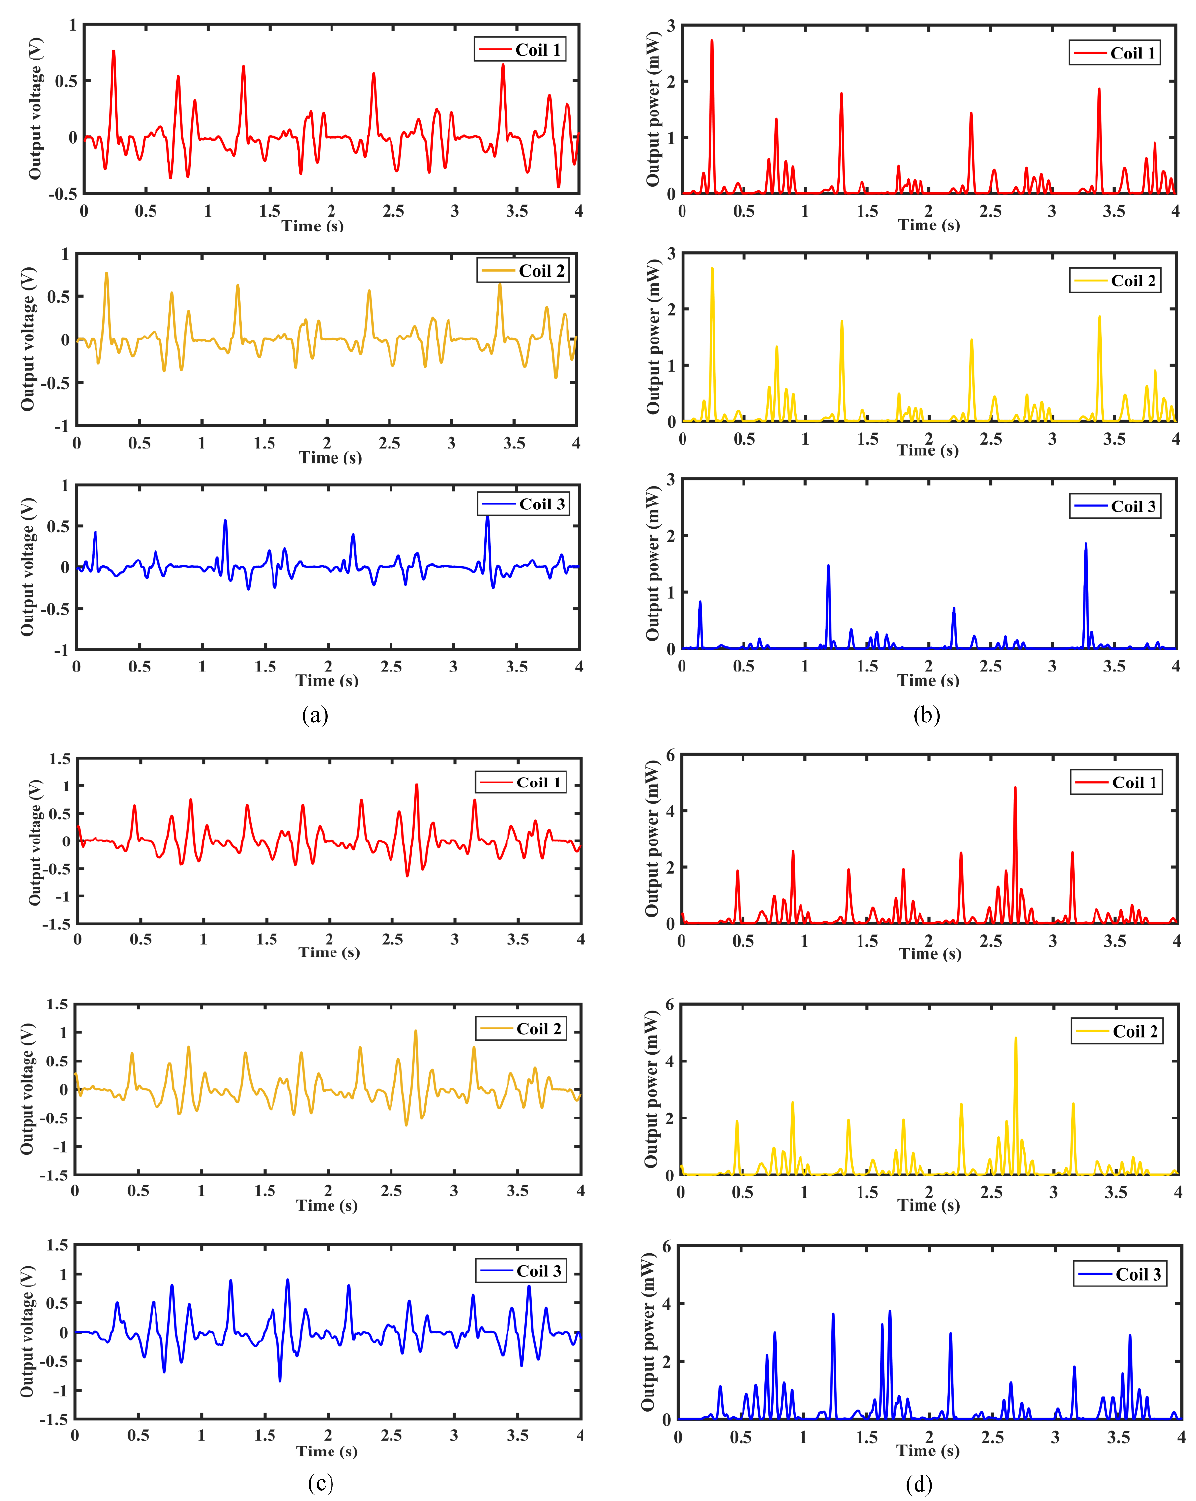
Figure 14. Output of the MCEEH installed parallel to the leg: ( a ) output voltage for moving speed at 3 km/h; ( b ) instanta- neous power output for moving speed at 3 km/h; ( c ) output voltage for moving speed at 6 km/h; ( d ) instantaneous power output for moving speed at 6 km/h.